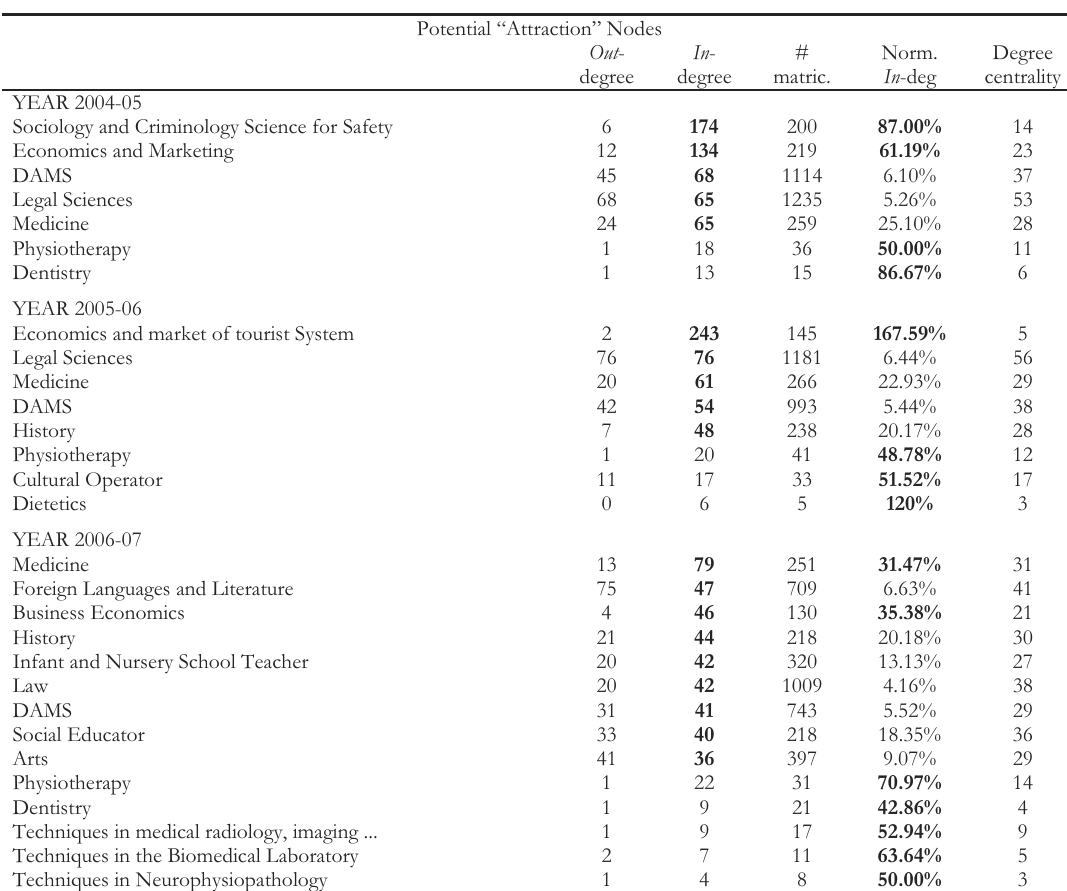
Potential “Attraction” degree courses Potential “Attraction” Nodes